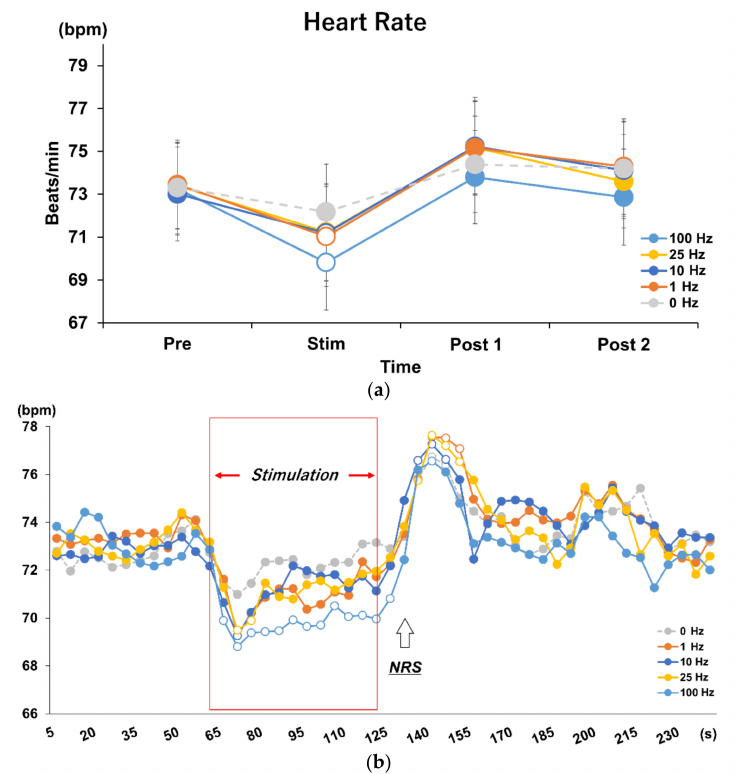
Figure 3. ( a ) Effects of different stimulus frequencies of tVNS on HR. The results of repeated measures two-way ANOVA showed main effects and interactions for frequency and time factors (F = 2.607, p = 0.003). The 100 Hz condition was the most effective in decreasing HR during stimulation compared to the other frequencies ( p = 0.001). White dots indicate significant differences. ( b ) Time course analysis on every 5 s in each stimulus frequency condition. Post hoc analysis using Dunnett’s method revealed different effects during stimulation and rebound after stimulation for each frequency ( p < 0.05). White dots indicate significant differences. Upward-pointing arrow indicates the timing of administration of the Numerical Rating Scale (NRS) for discomfort, which was taken 10 s after termination of the